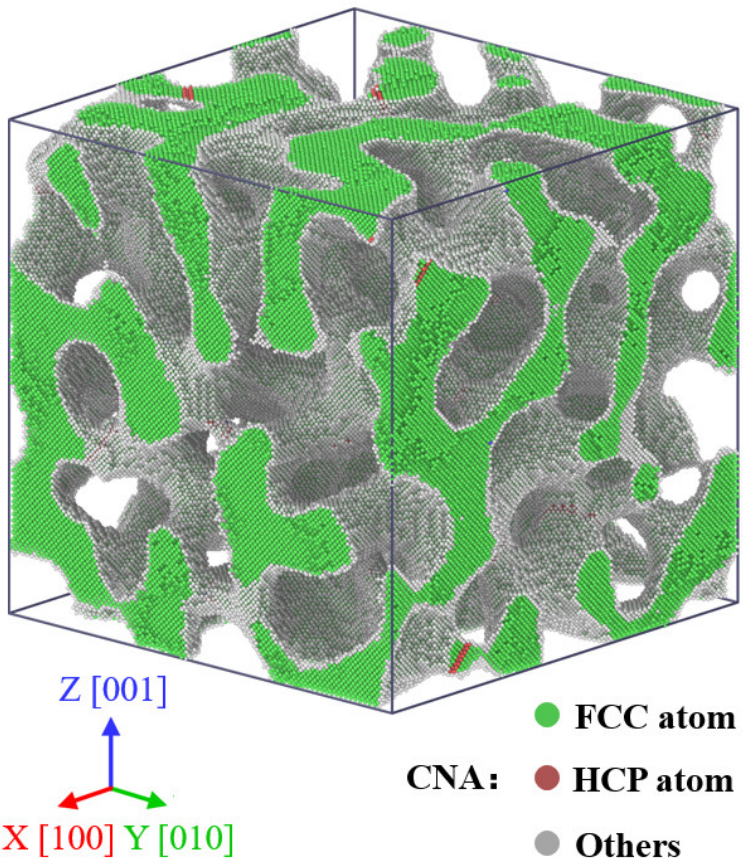
Figure 1. Atomic configuration of nanoporous gold with a relative density of ρ = 0.40 and an average ligament diameter of d = 4.7 nm. Atoms are colored by the CNA method, in which HCP atoms are colored red, FCC atoms are colored green, and other atoms are colored gray.